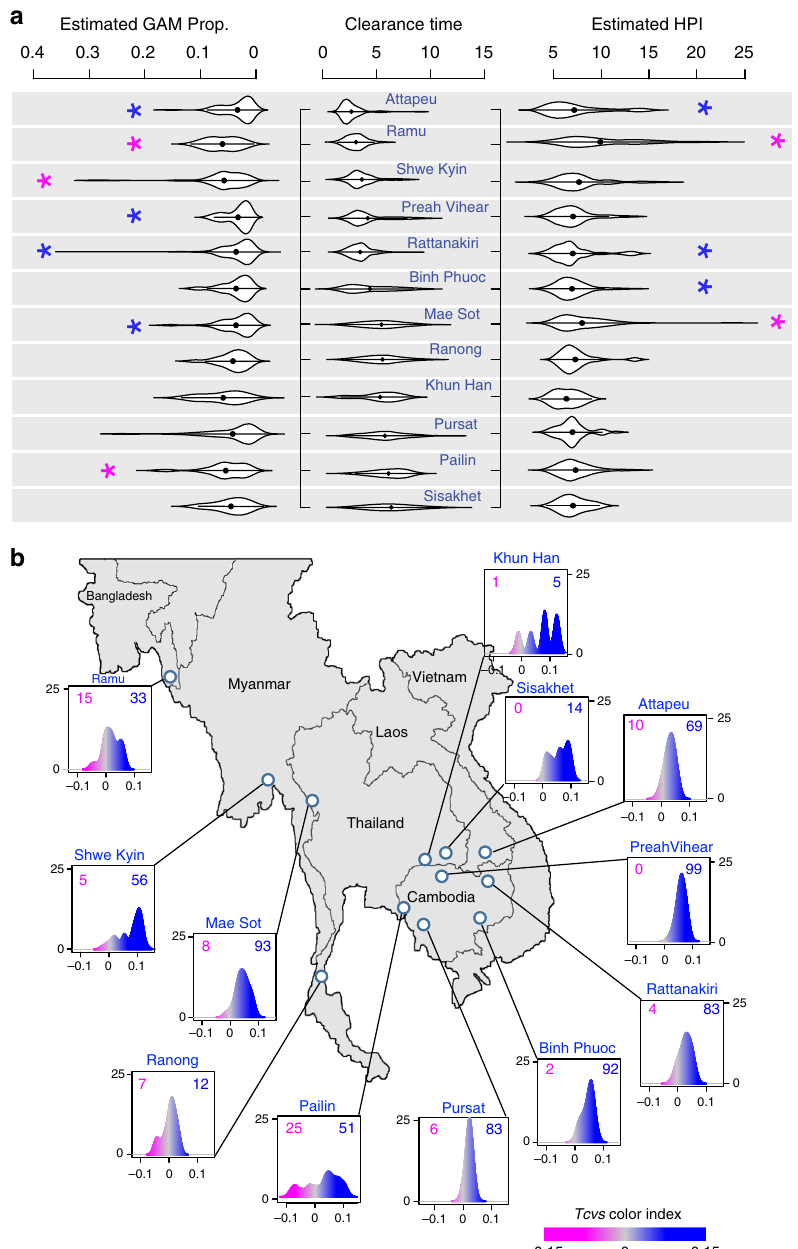
Fig. 1 P. falciparum transcriptome in the GMS. a Violin plot representing the distribution of estimated gametocyte proportion (GAM Prop.; left) and asexual parasite age (HPI; right) for all the GMS sites arranged in order of median parasites clearance time (in response to artemisinin treatment) (middle) from high to low. Black dot within violin indicates the statistical mean of each category. Magenta (blue) asterisks denote signi fi cantly high (low) values at p - value < 0.05 (Wilcoxon rank-sum test). b Distribution of Tcvs is displayed in density plot to show the local convergence of parasite transcriptome at each TRACI-study sites of the 773 isolates. The color from magenta to gray to blue represents the Tcvs scores from negative to zero to positive. The isolates number with Tcvs > 0 (blue number) and Tcvs ≤ 0 (magenta number) are shown together with the density plot at each site. The geographic map